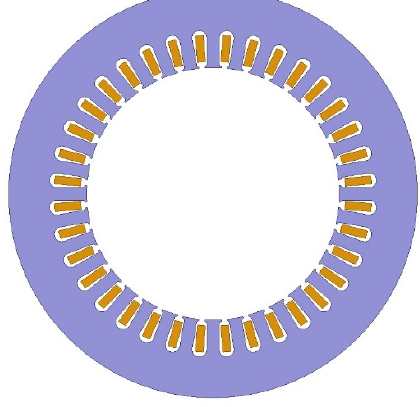
Figure 4. Stator of the HEPMa-SynRM.